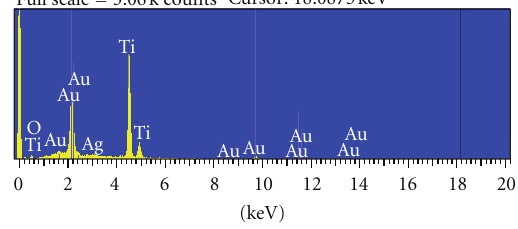
Figure 3: EDX of Ag-TiO 2 sintering at 550 ◦ C.